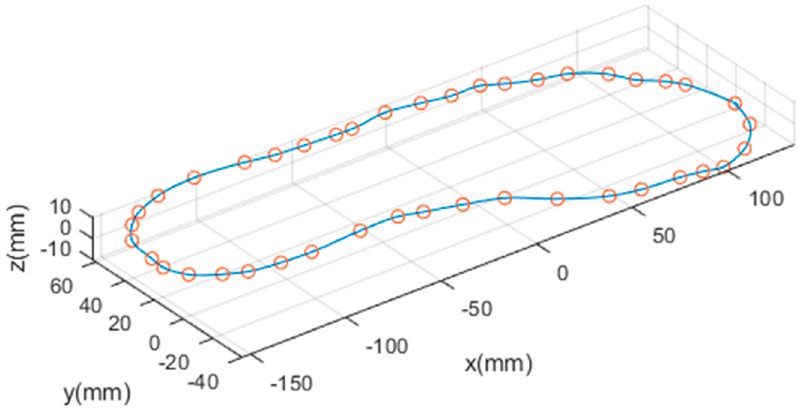
Figure 18. Sampled points and mapped out path using 43 points.